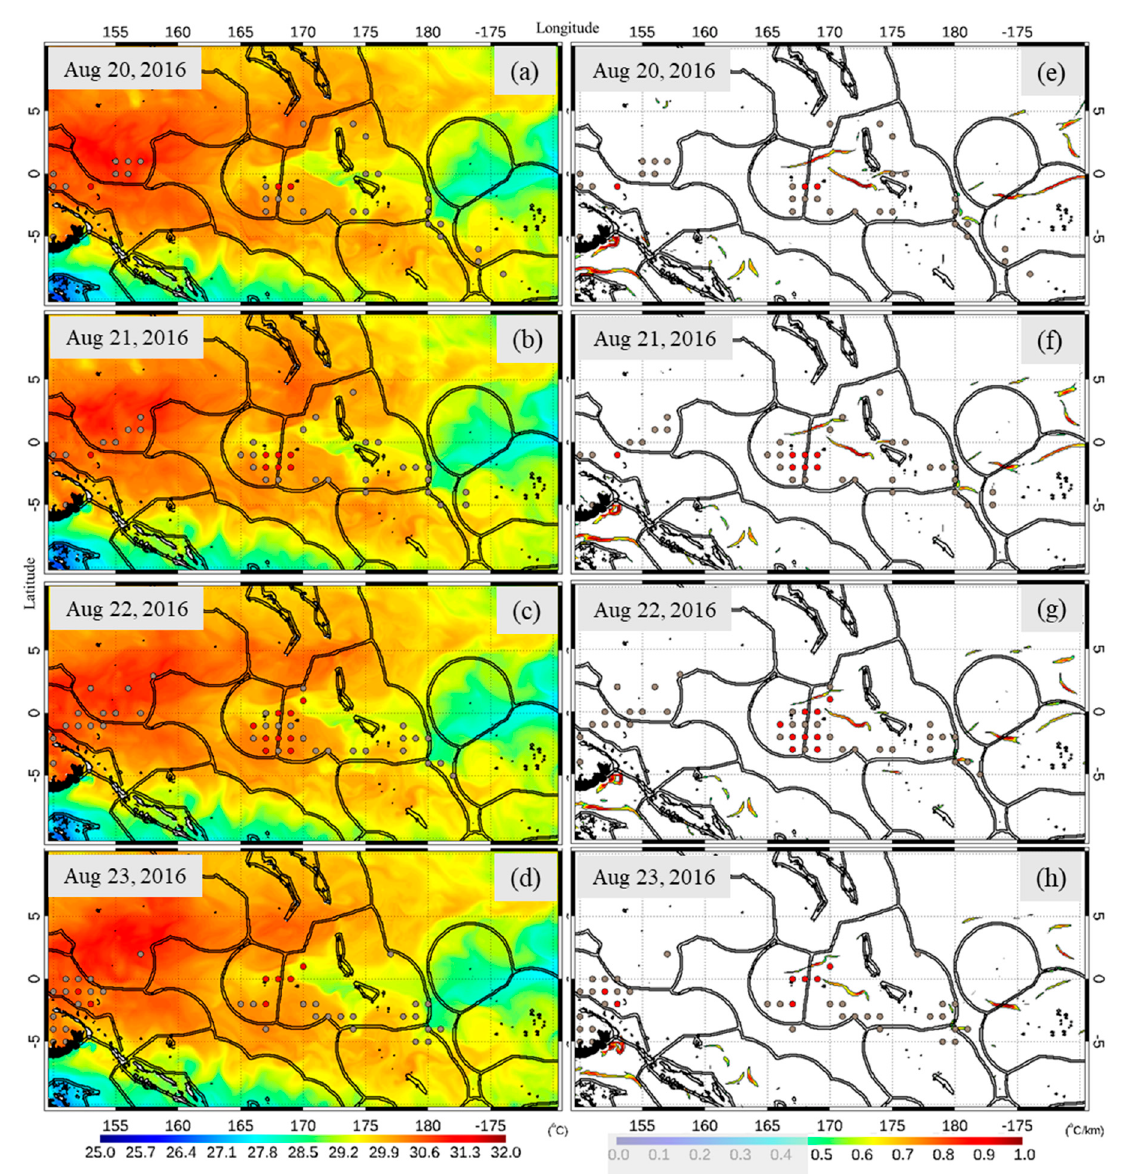
Figure 8. Spatial distribution of skipjack tuna fishing locations (global and Taiwanese data, gray and red circles, respectively) overlaid on daily ( a – d ) SST and ( e – h ) SST front images in the period of 20–23 August 2016. The SST fronts below 0.5 are transparent to emphasize the strong fronts.